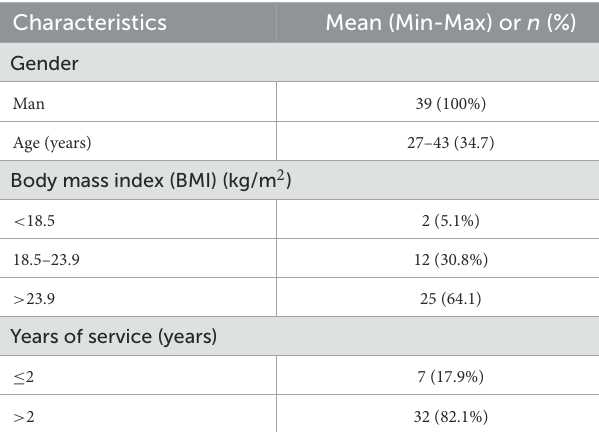
TABLE 1 Characteristics of the